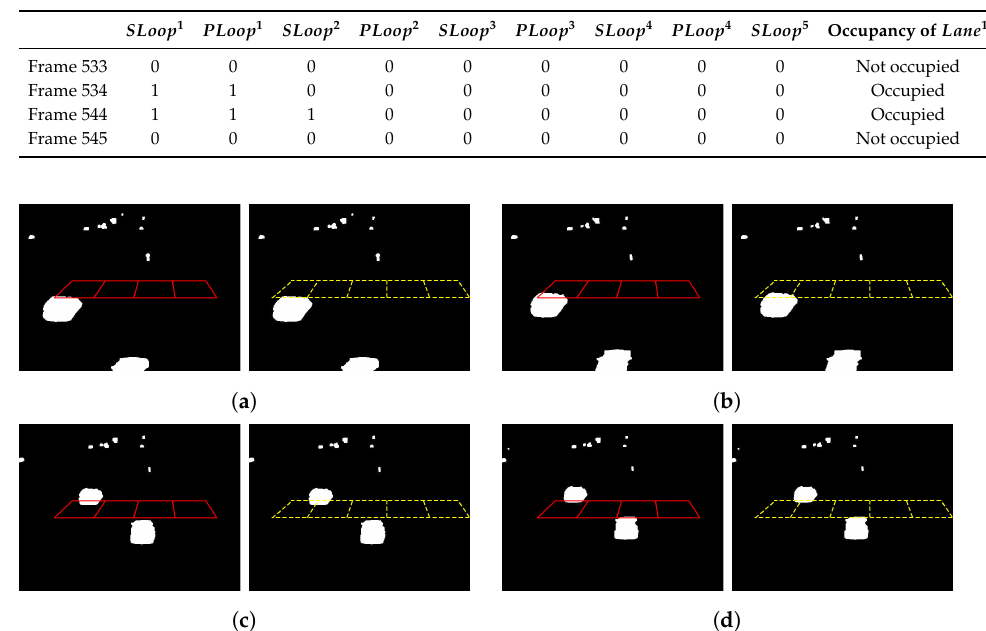
Table 6. The state of loops at the four key frames of the left black vehicle in Figure 2a.